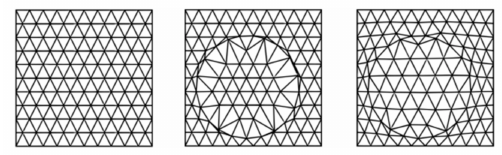
Figure 4. Three-step process of mesh generation.